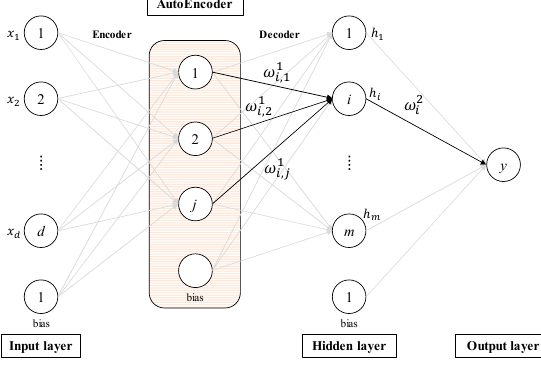
Figure 4. Schematic diagram of MLP regression.